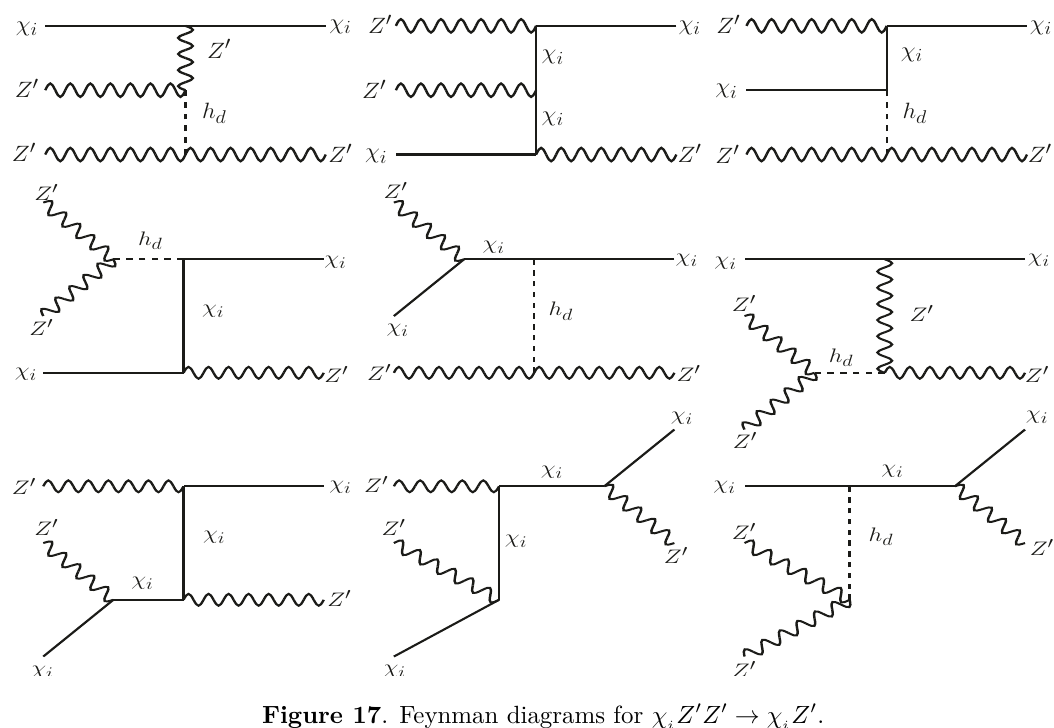
Figure 17 . Feynman diagrams for χ